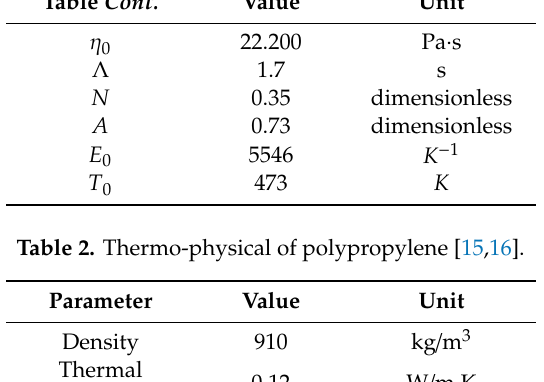
Table 1. Carreau–Yasuda parameters for polypropylene [14]. Table Cont.